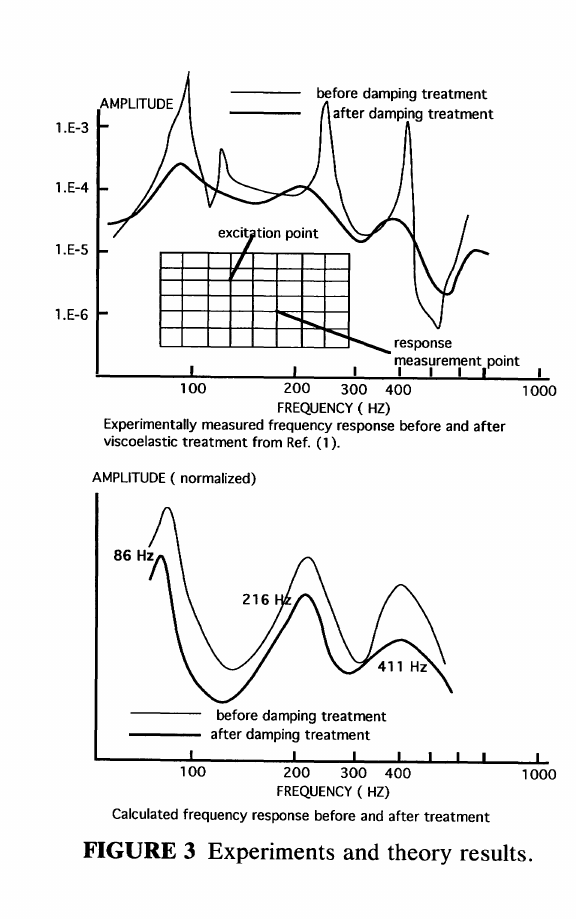
FIGURE 3 Experiments and theory